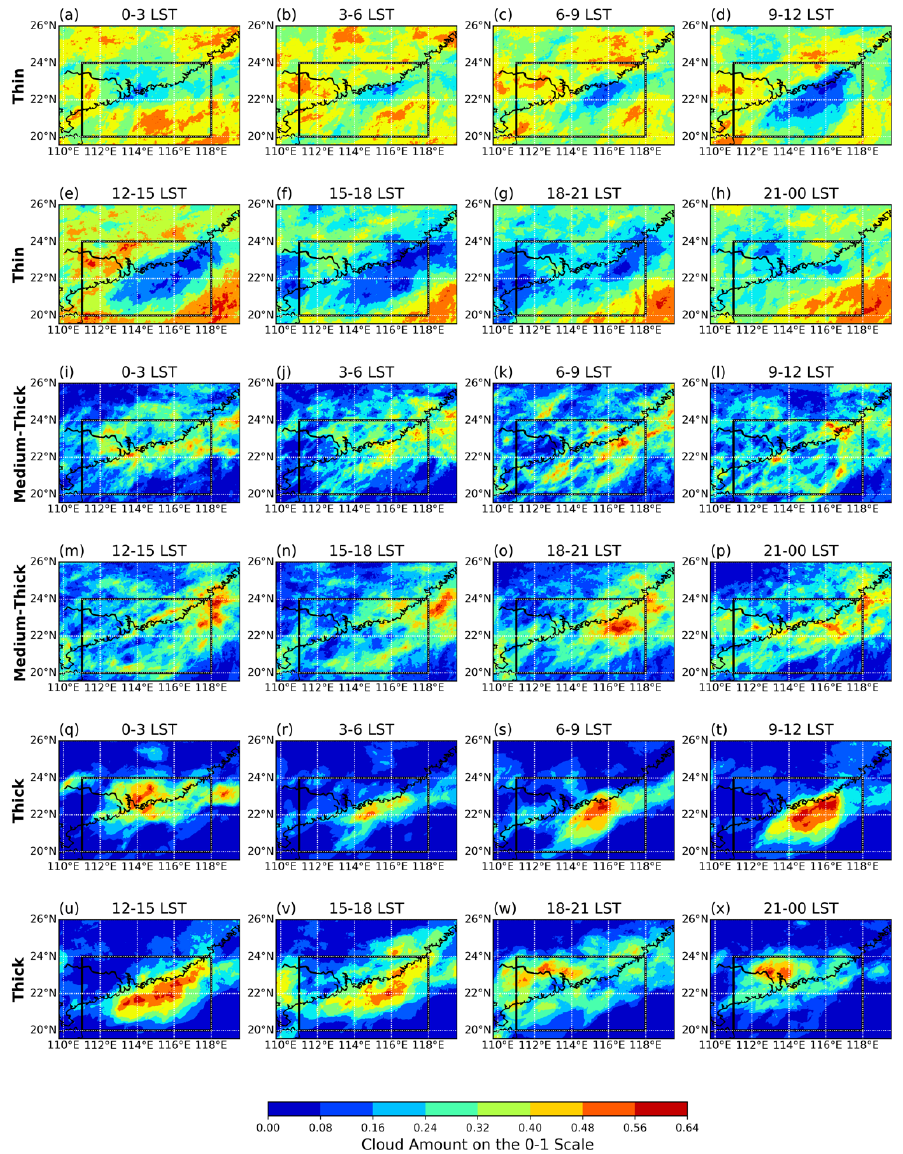
Figure 8. Daily mean cloud amount evolution over the SCCA within a 3 h interval. The first two rows ( a – h ) present the thin ice clouds results, the next two rows ( i – p ) show the medium-thick ice-cloud results, and the last two rows ( q – x ) show the thick ice cloud results.